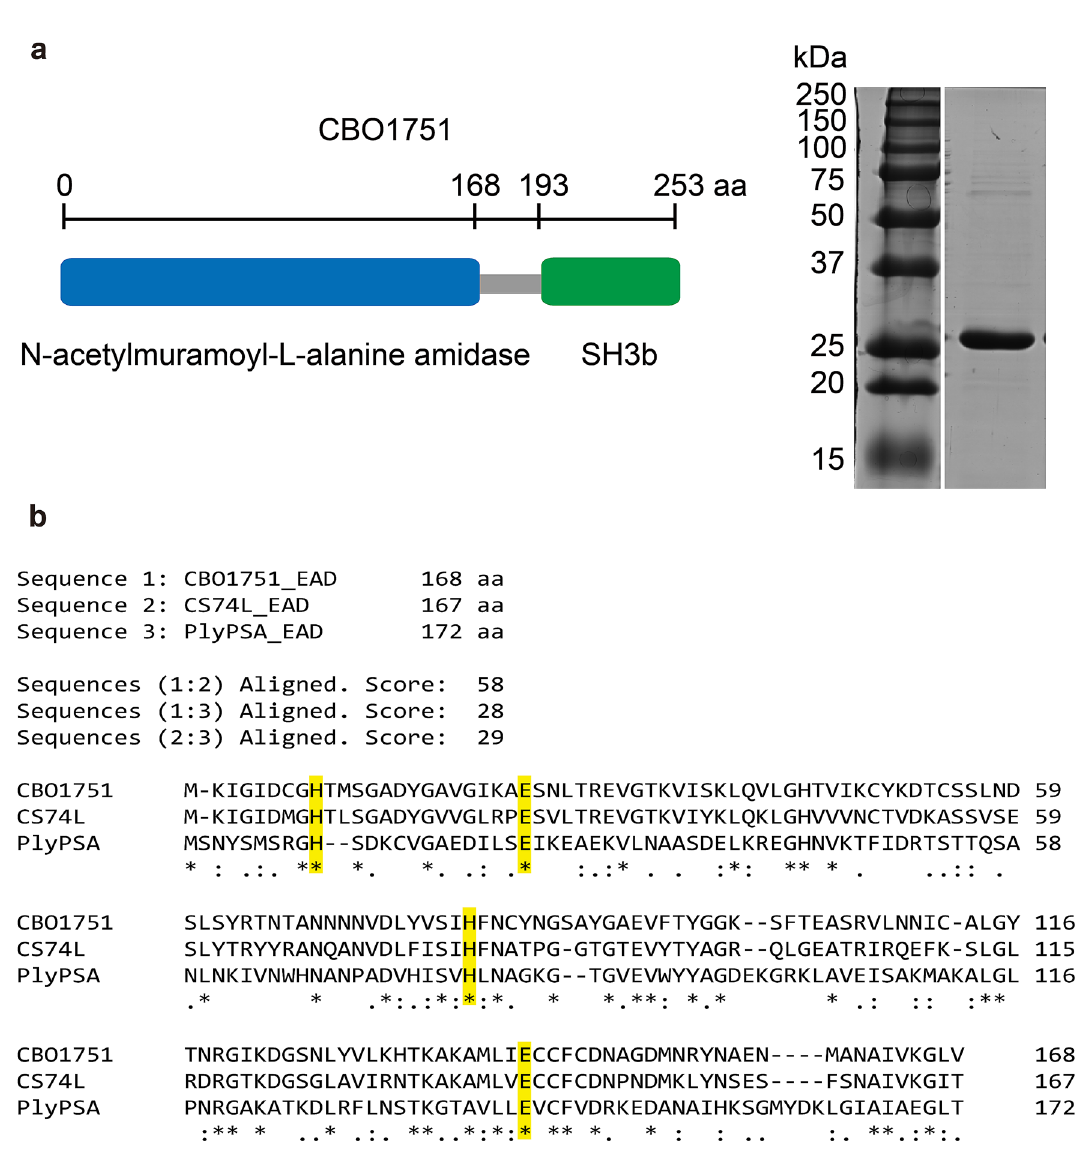
Figure 1. Features of CBO1751. ( a ) Schematic representation of the two domains of CBO1751 and SDS-PAGE analysis of purified CBO1751. Left lane of gel image, Precision Plus Protein Dual Color Standards (Bio-Rad, Hercules, USA). Right lane, eluted his-tagged CBO1751. The original gel is shown in Supplementary Fig. S2. ( b ) Amino acid sequence alignment of amidase EAD of CBO1751 with Clostridium sporogenes CS74L and Listeria monocytogenes PlyPSA. The conserved catalytic residues are marked in